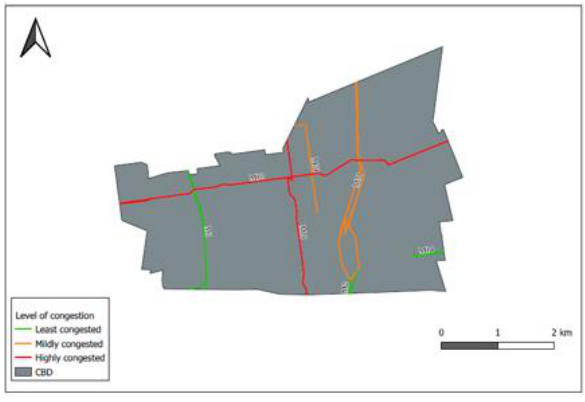
Figure 6 . Roads in Johannesburg CBD susceptible to traffic